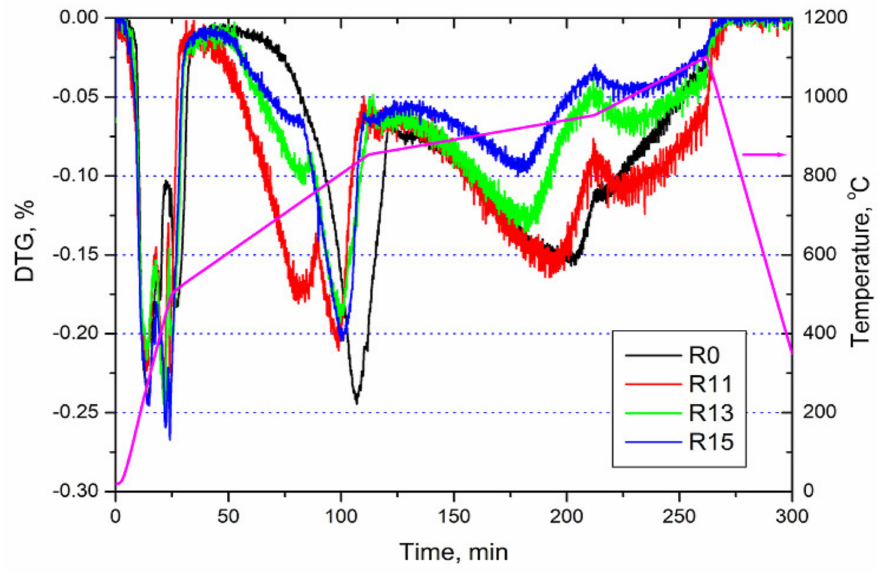
Figure 7. The first derivative (DTG) of the mass loss curves as a function of time and temperature.